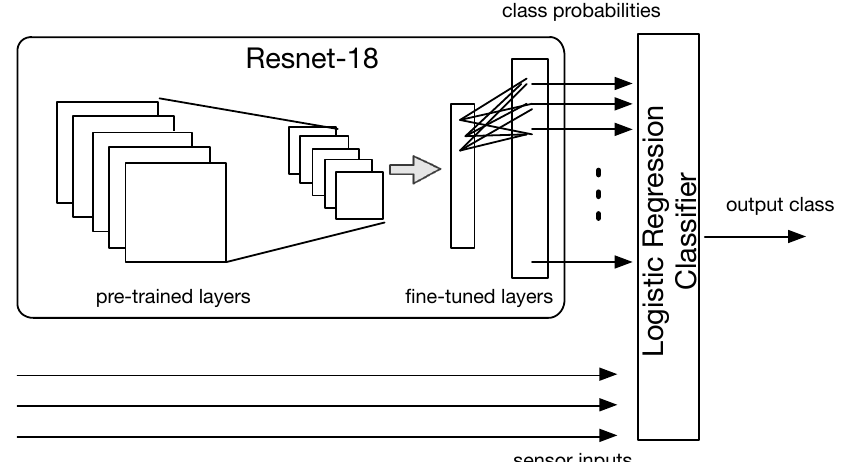
Figure 11. Integration at learning time.